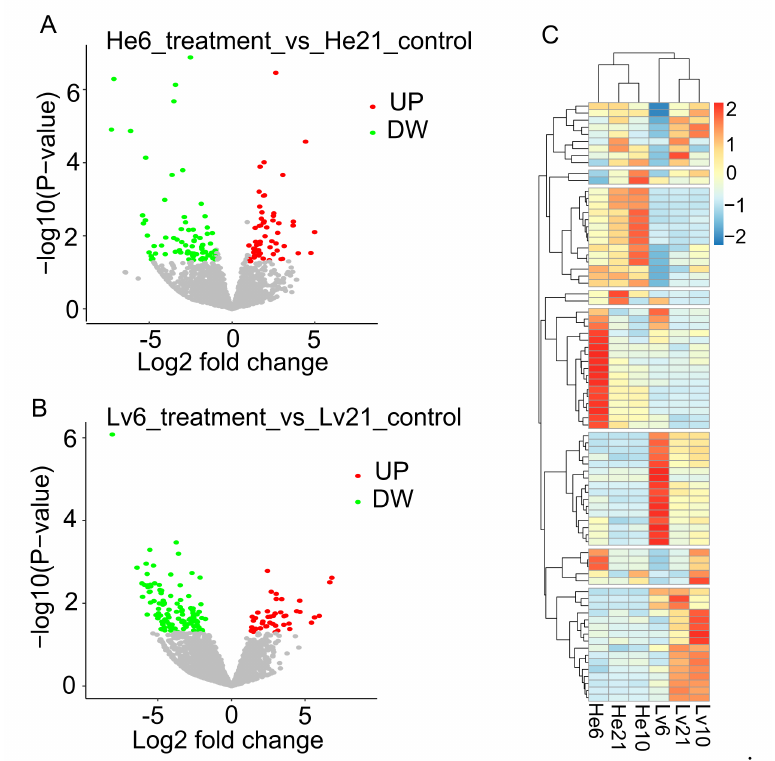
Figure 3. The volcano and heatmap plots of DE-lncRNAs. ( A ) Volcano plot for DE-lncRNAs under 6.5% vs. 21% O 2 in heart. The X -axis shows the log2 fold changes of DE-lncRNAs, and Y -axis shows the − log10 ( p -value) (Wald test). Red dots in the volcano plot represent the up-regulated DE-lncRNAs, and green dots represent the down-regulated DE-lncRNAs in 6.5% O 2 treatment group compared with 21% O 2 as control group in heart tissue. ( B ) Volcano plot for DE-lncRNAs under 6.5% O 2 vs. 21% O 2 in liver. ( C ) The heatmap of DE-lncRNAs, the expression levels were scaled by row. DE-lncRNAs: differential expressed lncRNAs; UP: up-regulated; DW: down-regulated. He6: heart tissue under 6.5% O 2 concentration; He10: heart tissue under 10.5% O 2 concentration; He21: heart tissue under 21% O 2 concentration; Lv6: liver tissue under 6.5% O 2 concentration; Lv10: liver tissue under 10.5% O 2 concentration; Lv21: liver tissue under 21% O 2